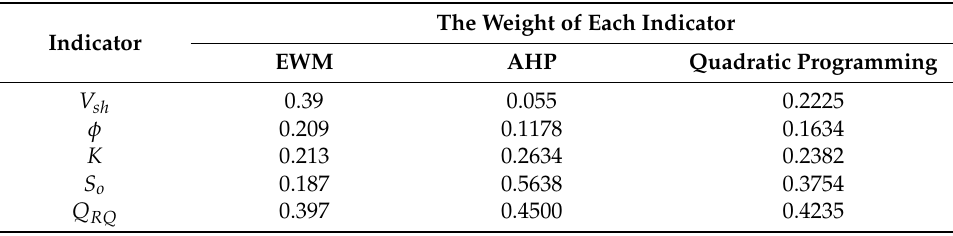
Table 1. Each indicator weight of reservoir